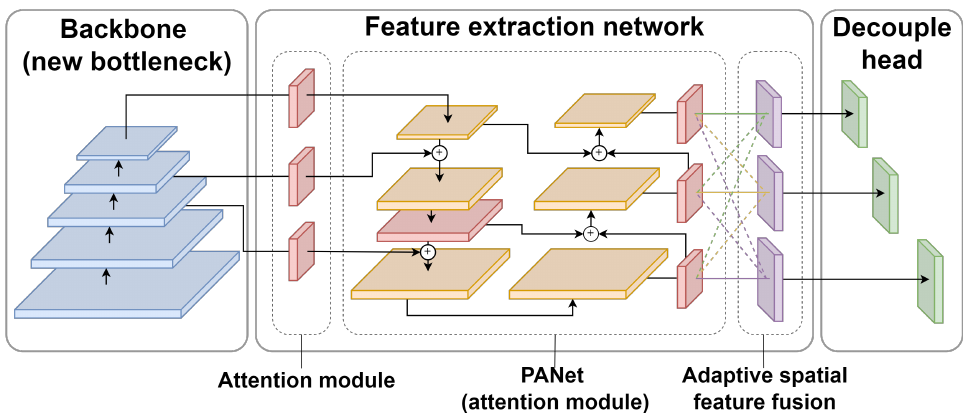
Figure 1. An overview of the detection network. The blue block is the backbone, the red block is the attention module, the orange block is PANet, the purple block is the adaptive spatial feature fusion, and the green is the decouple